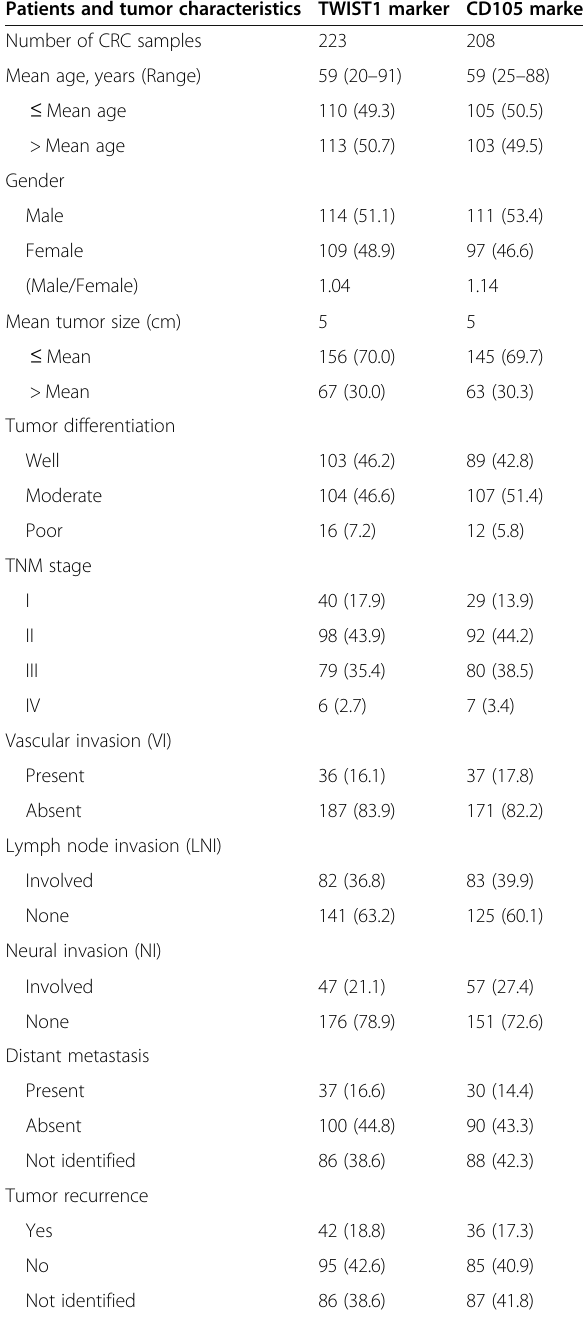
Table 1 Patients and tumor pathological parameters of the studied population Patients and tumor characteristics TWIST1 marker CD105 marker Number of CRC